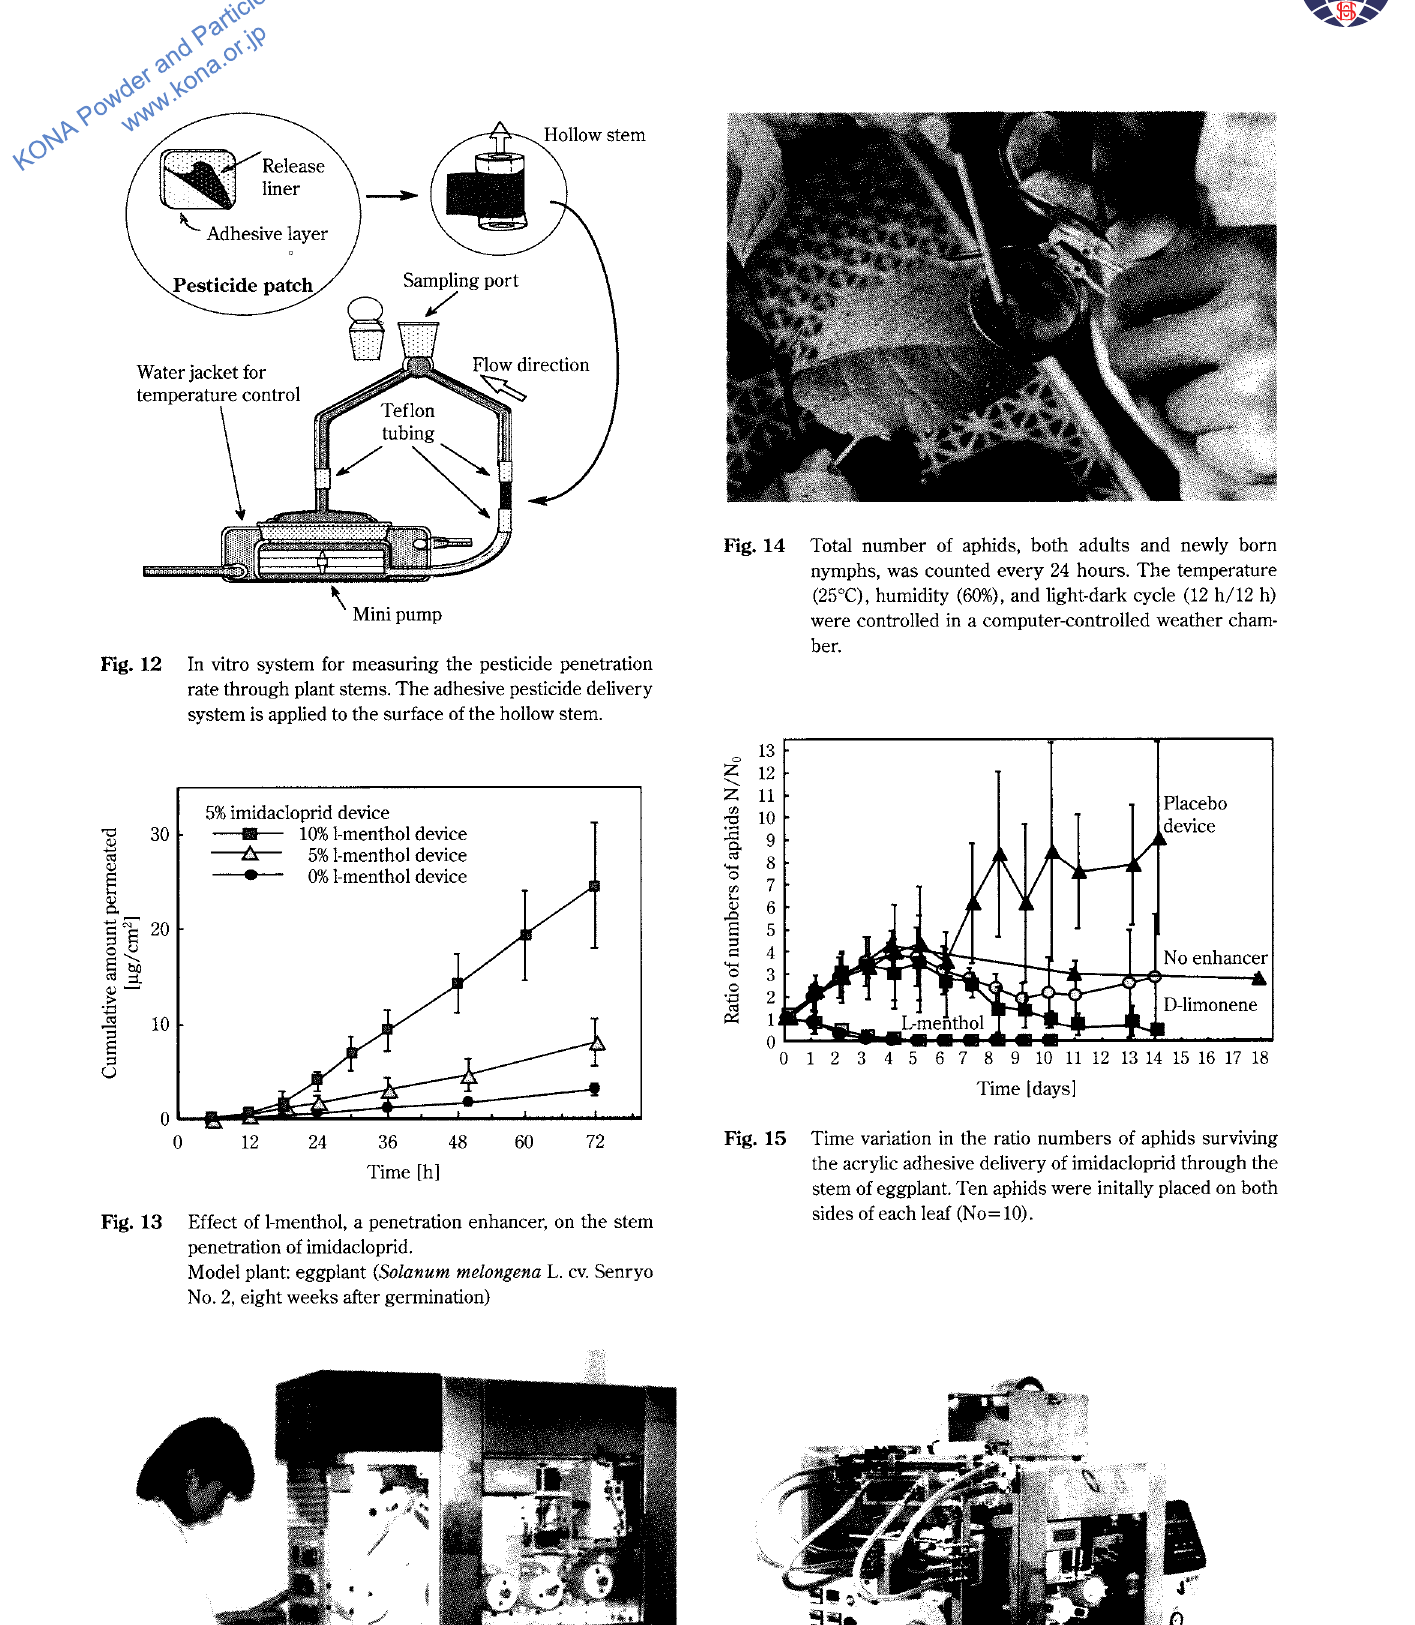
Laboratory-scale equipment for manufacturing transdermal drug delivery devices. (a) Solvent method, (b) hot-melt